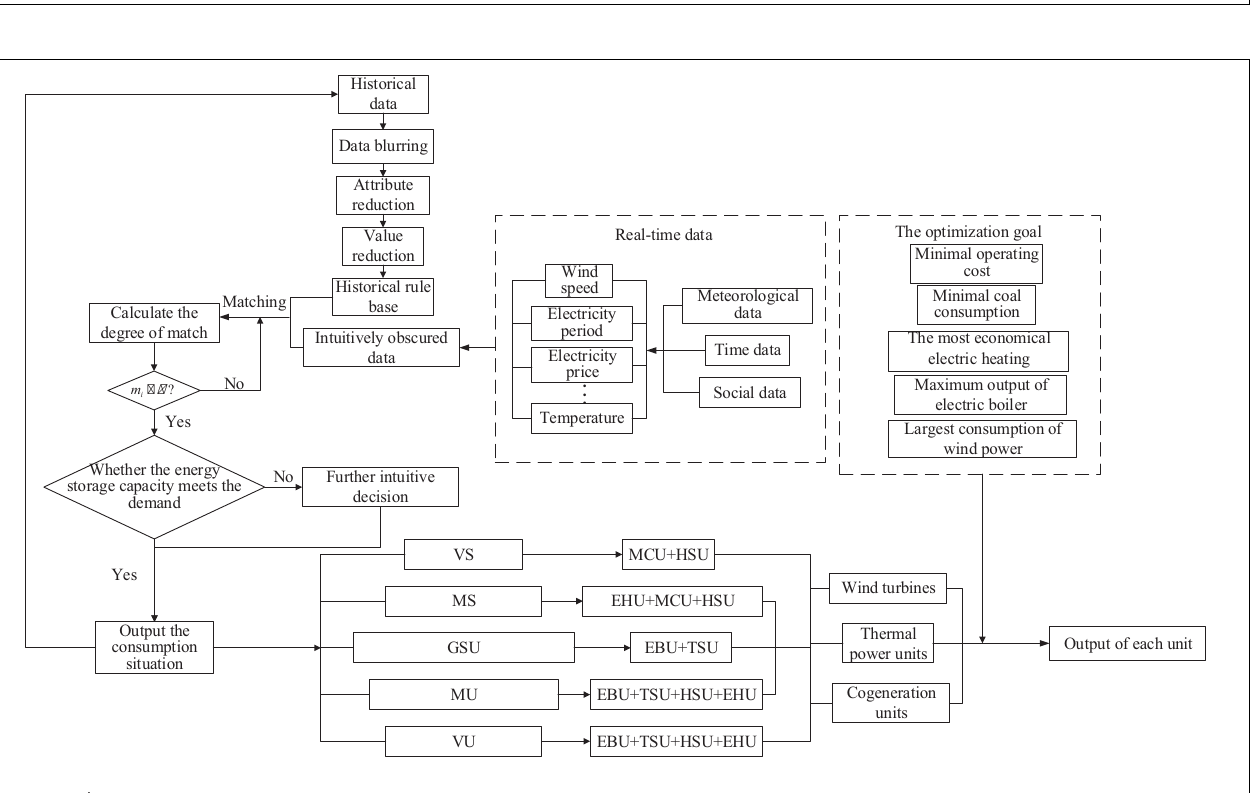
FIGURE 6 | System optimization objectives and constraints under each consumption state.